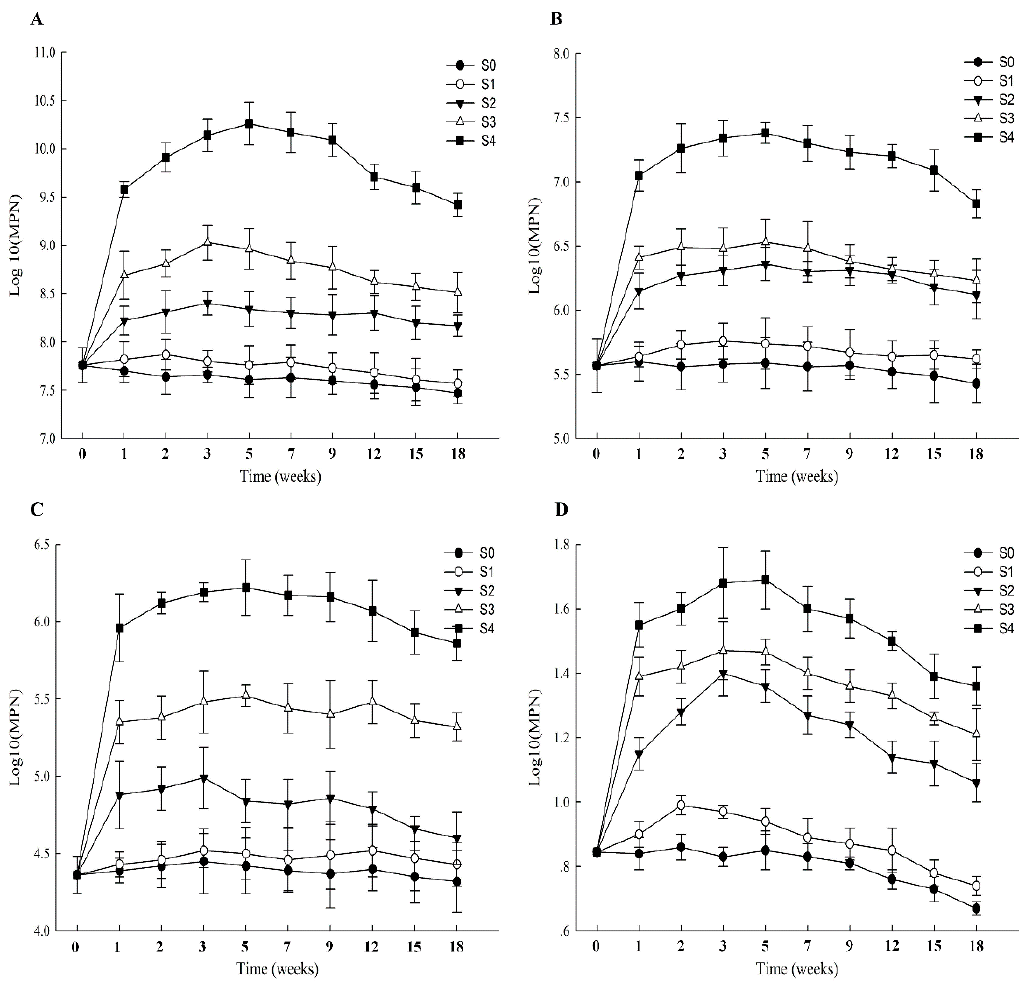
Figure 4. Numbers of PH degraders. Graphs ( A – D ) represent the numbers of heterotrophic microorganisms, TPH-degraders, ALK-degraders, and PAH-degraders, respectively.